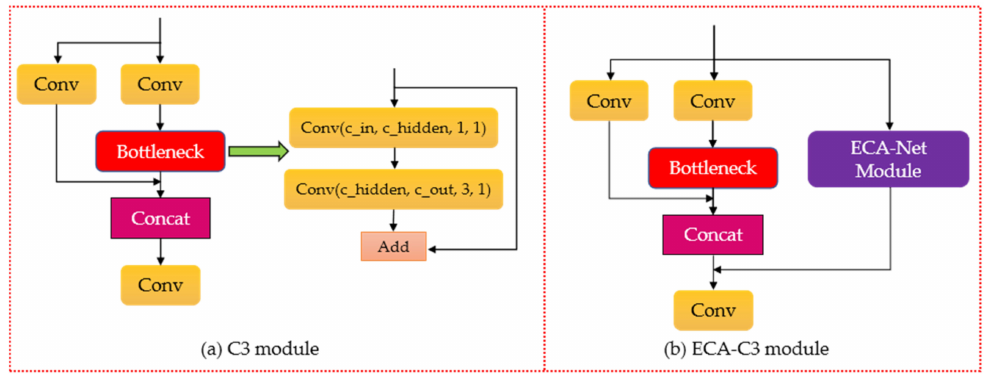
Figure 4. The architecture of the C3 and ECA-C3 modules.